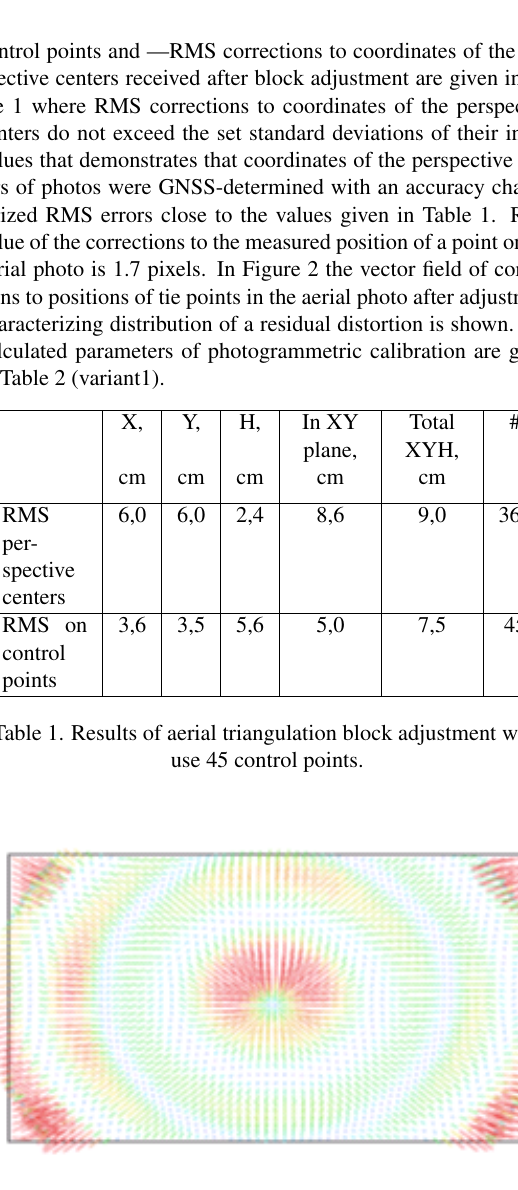
Figure 2. Characteristic picture of the vector field of corrections to positions of tie points on aerial image after